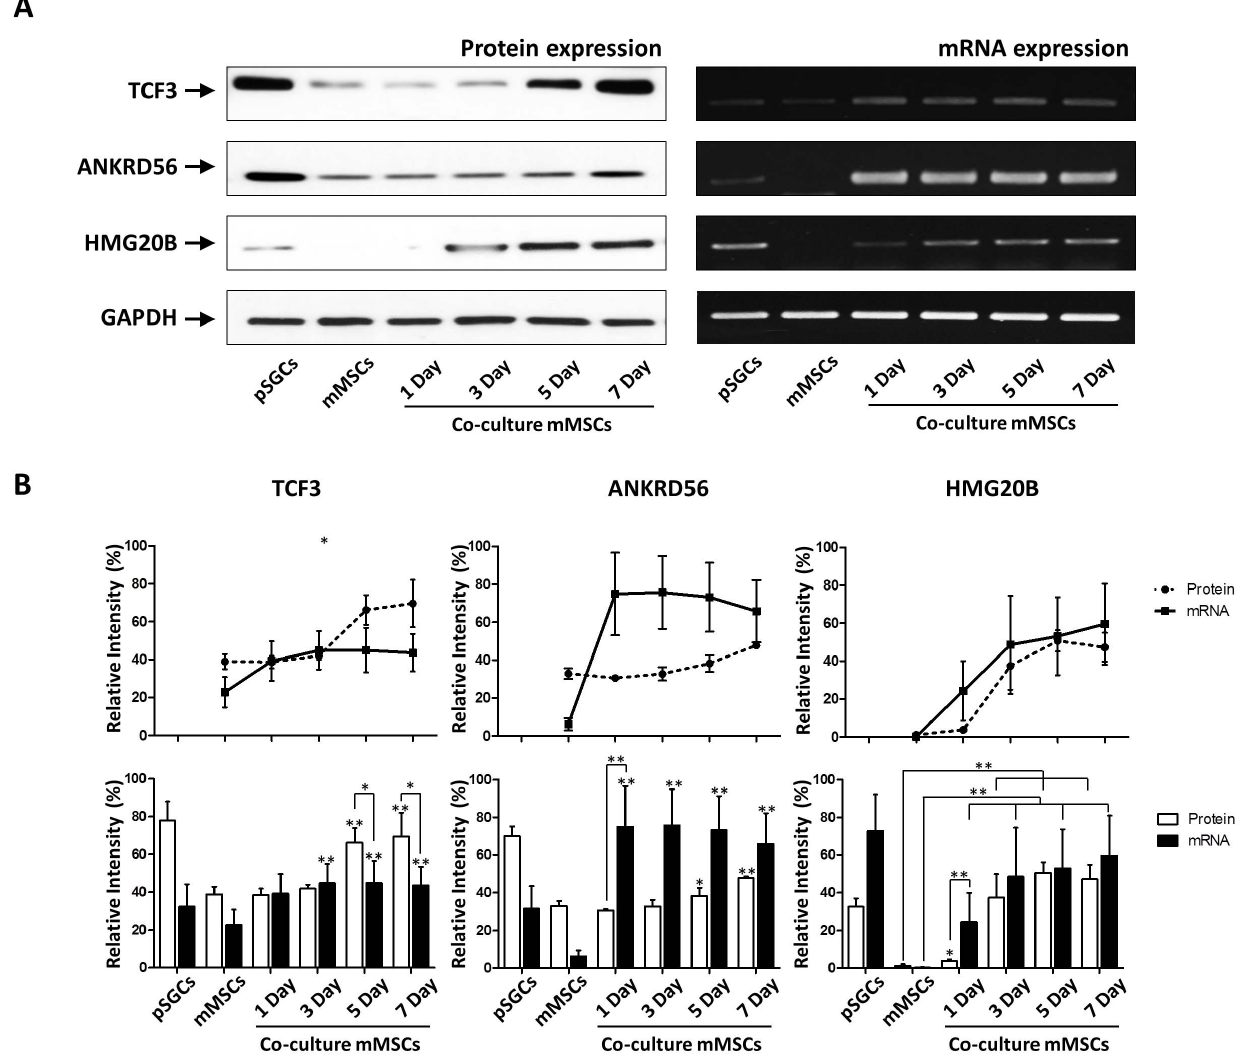
Figure 6. Quantitative analyses of ANKRD56, HMG20B and TCF3 expression using western blotting and RT-PCR. A) Total protein lysate and mRNA samples isolated from the pSGCs derived from the submandibular gland tissue of 4 week-old B6 mice were used as a positive control. GAPDH protein was used for a loading control. Tcf3, hmg20B and Ankrd56 proteins were analyzed in pSGCs and co-cultured mMSCs. B) Densitometer analyses of salivary acinar cell markers, such as a -AMY, M3R and AQP-5, were analyzed in three independent replicates (p , 0.05, one-way ANOVA with Bonferroni post-hoc test).